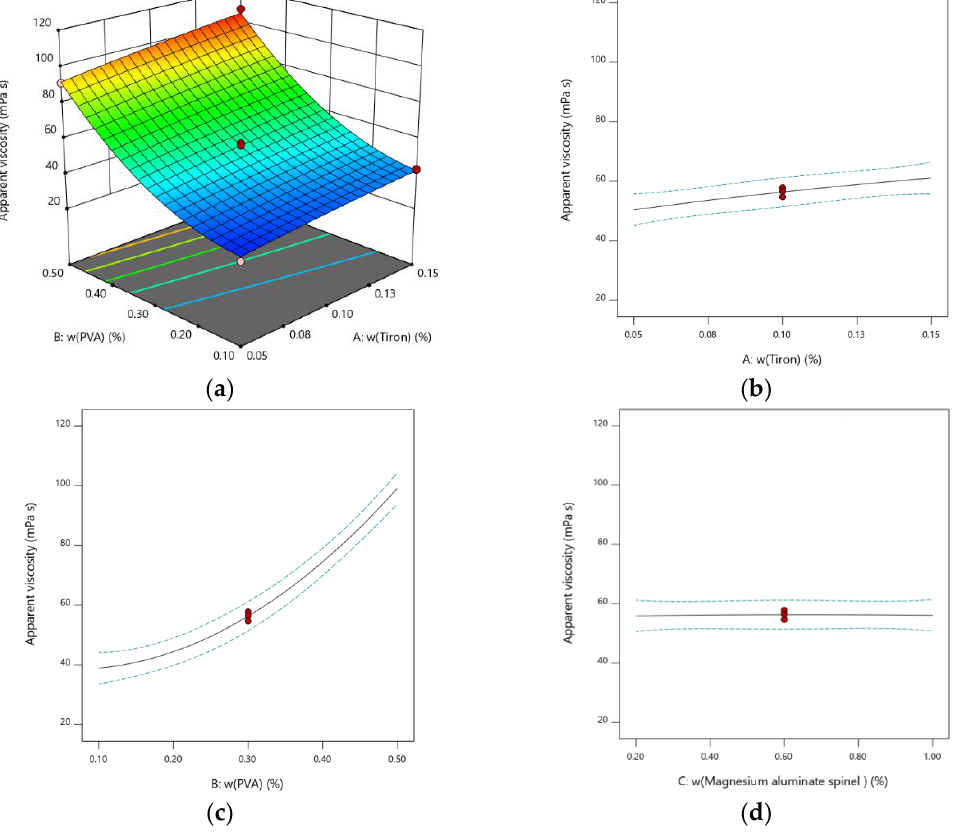
Figure 2. The effect on apparent viscosity of 70 wt.% Al 2 O 3 suspensions which contain 20 dwb.% waste Al 2 O 3 powder: ( a ) 3D-plot of viscosity on two factors (PVA content and Tiron content); ( b ) Tiron; ( c ) poly (vinyl alcohol) (PVA); ( d ) magnesium aluminate spinel (MgAl 2 O 4 ).